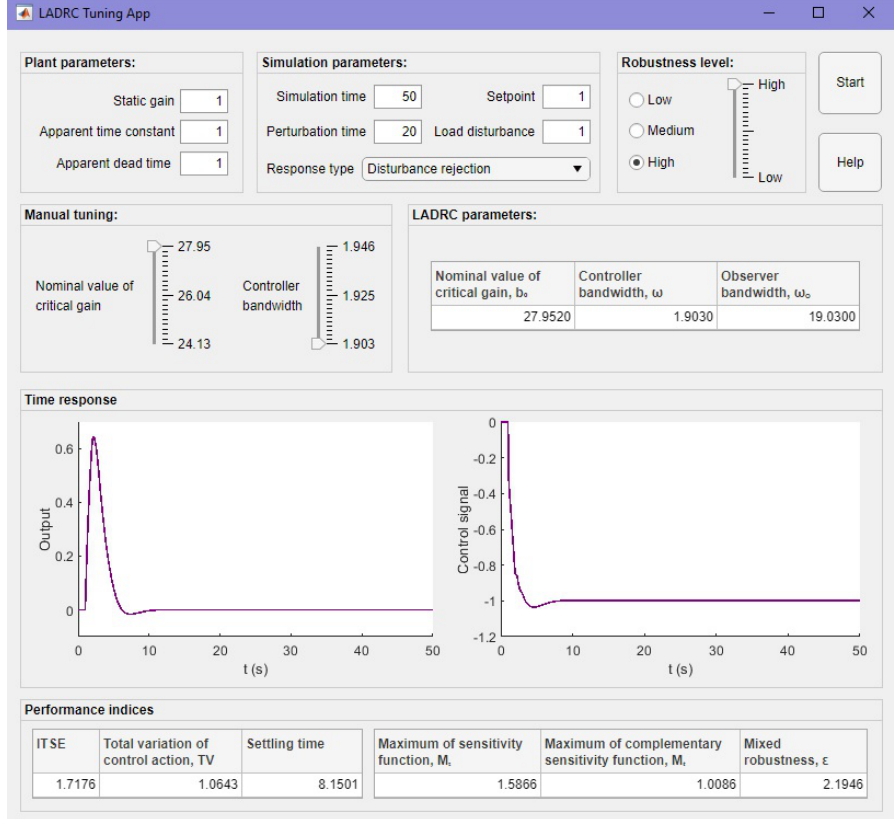
Figure 11. LADRC tuning tool. This Matlab App allows the automatic computation of the nominal value of the critical gain b 0 , the controller bandwidth ω c , and the observer bandwidth ω o of the second-order LADRC for the control of a system approximated by a FOPDT model. Available at